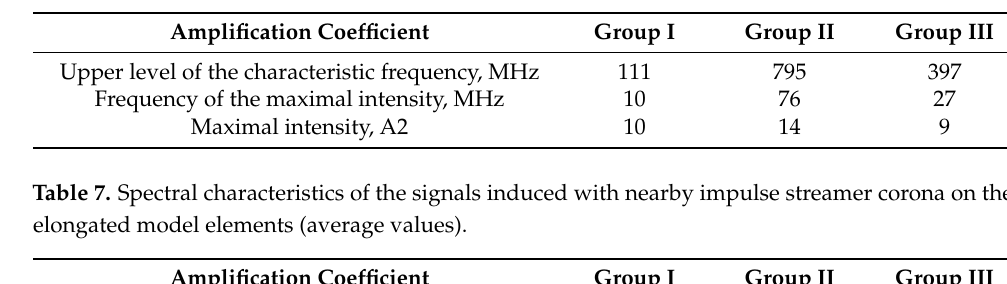
Table 6. Spectral characteristics of the signals induced with nearby impulse streamer corona on the rod model elements (average values).